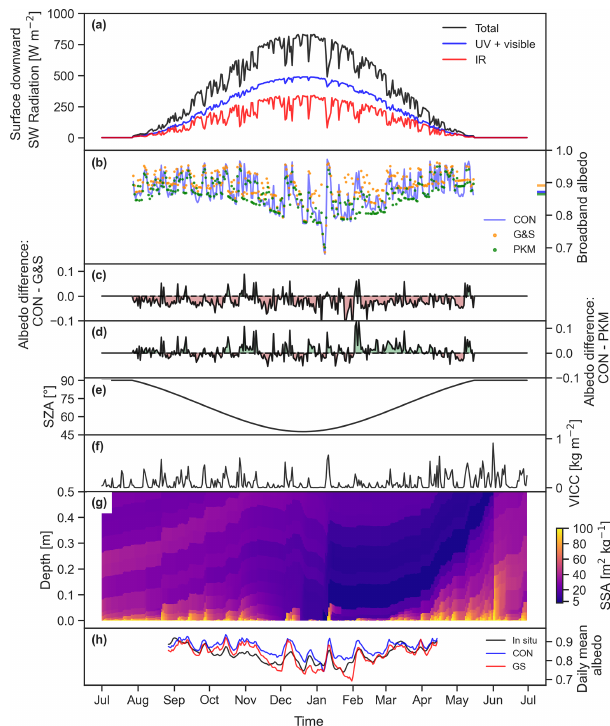
Figure 9. Time series at Neumayer for 2012–2013, 12:00UTC (12:00LT). (a) Instantaneous surface downward shortwave radia- tion, split into infrared (IR), ultraviolet (UV) and visible radiation; (b) instantaneous broadband albedo for CON, the parameterization of Gardner and Sharp (2010) (G&S) and Kuipers Munneke et al. (2011) (PKM). The horizontal lines on the right indicate the mean. (c) Albedo difference CON – G&S and (d) CON – PKM; (e) solar zenith angle (SZA); (f) vertically integrated cloud cover (VICC), which is the summation of the liquid and ice water path; (g) SSA as a function of depth for CON and (h) daily mean albedo for CON, GS and in situ